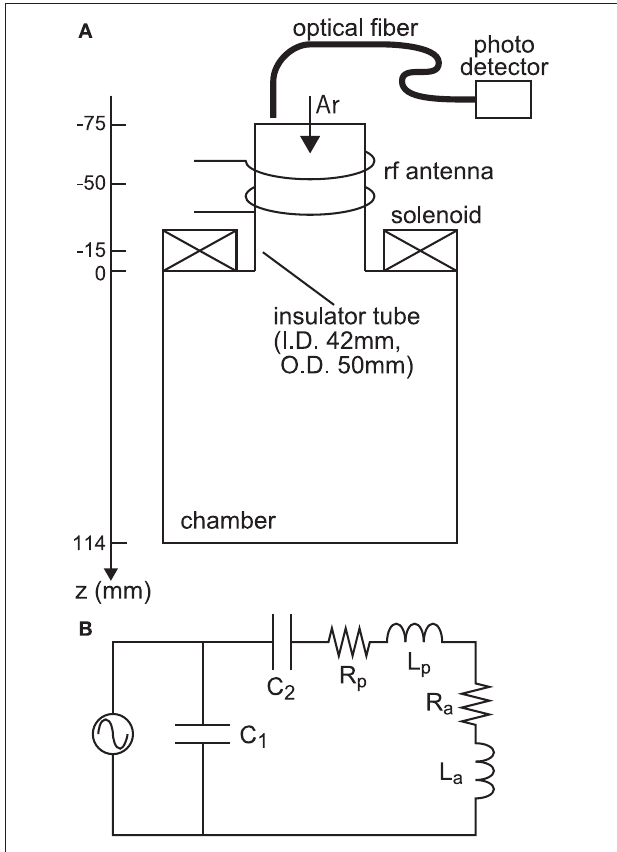
FIGURE 1 | (A) Schematic diagram of a weakly magnetized rf plasma source attached to the 114 mm 3 vacuum chamber. (B) Schematic of an impedance matching circuit containing a plasma resistance R p and a plasma inductance L a , where C 1 and C 2 are chosen as 390 and 73 pF, respectively. L a and R a are the antenna inductance and resistance,